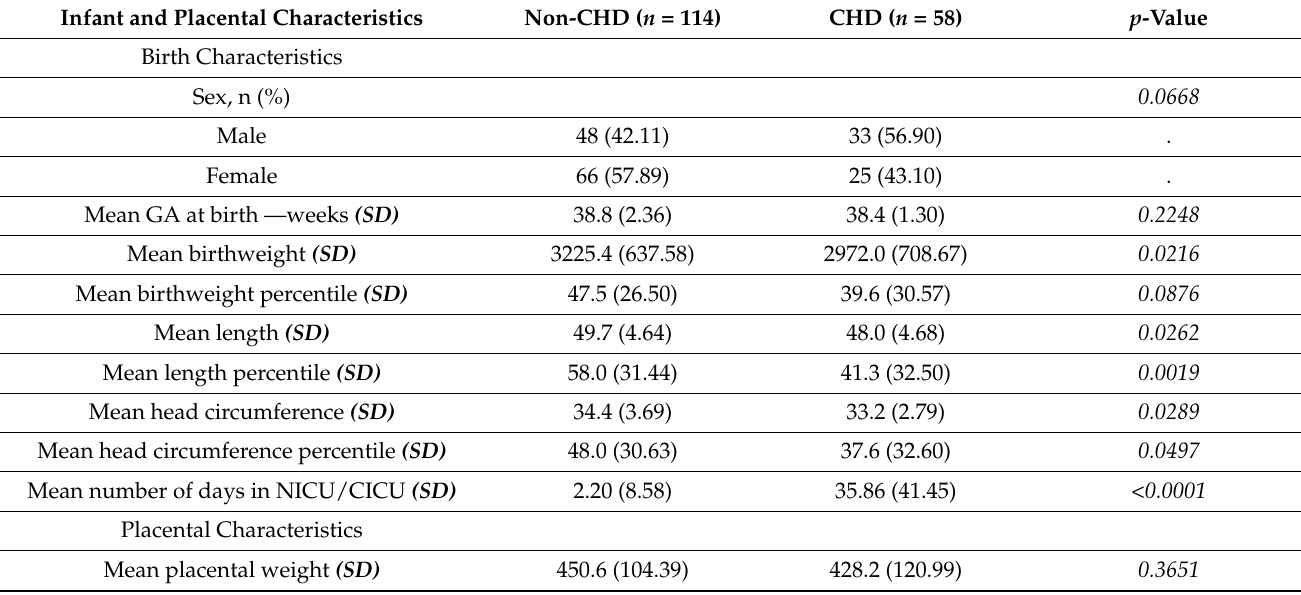
Table 3. Infant and Placental Characteristics of the CHD and Non-CHD